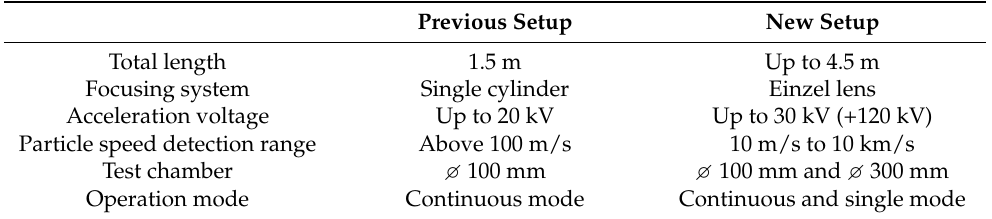
Table 1. Comparison of previous small accelerator and upgraded